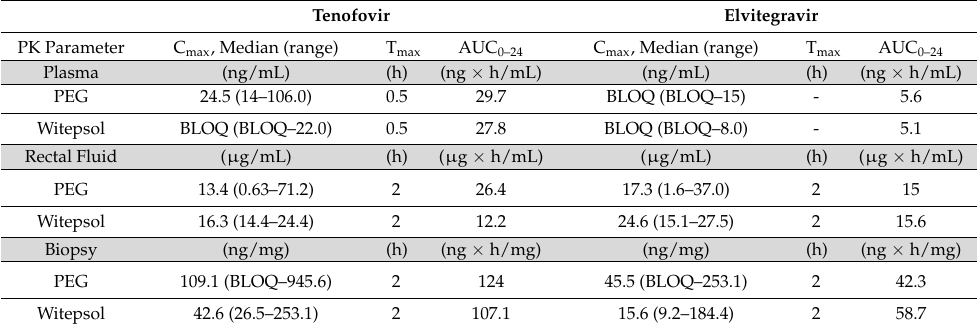
Table 2. Pharmacokinetic summary in macaques following rectal administration of TFV/EVG (40 mg/40 mg) suppositories formulated in witepsol H15 or PEG base.